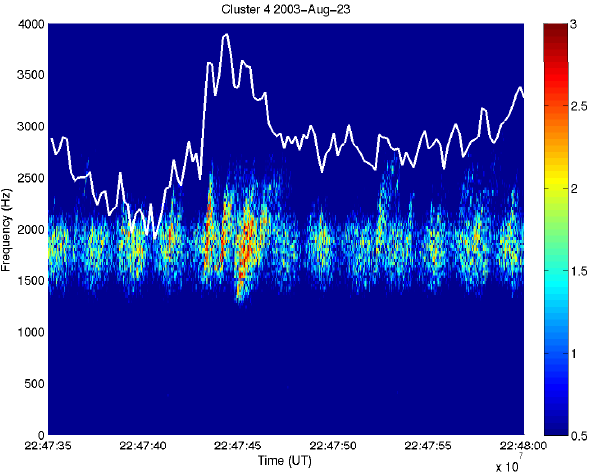
Fig. 1. Dynamic spectra of wave observations by the Cluster 4 WBD instrument for the period 22:47:30–22:28:00UT. The white line represents the spacecraft potential and is used as a proxy mea- surement for the plasma electron density (suitably